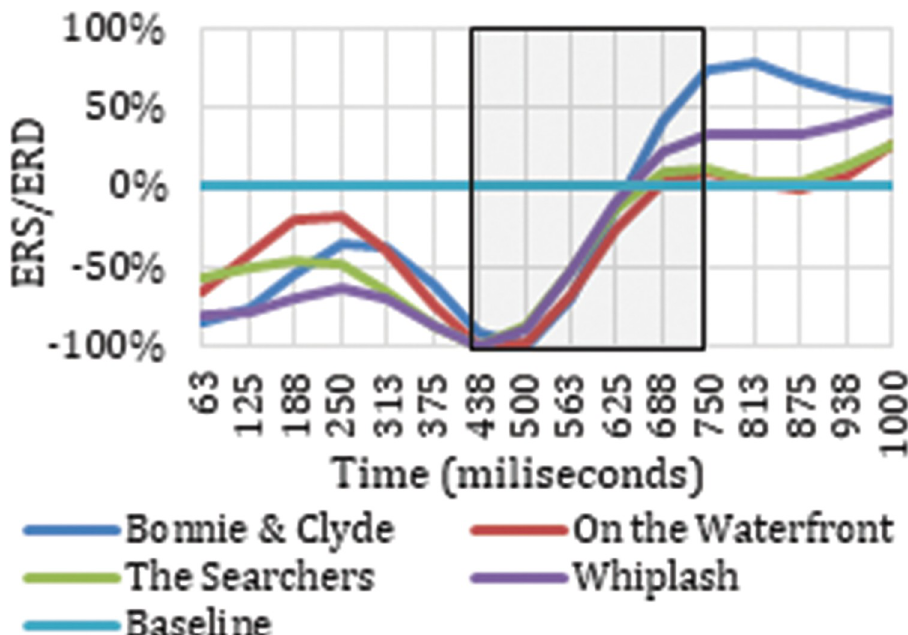
Fig 11. ERD/ERS from the four film excerpts for P4 electrode in low delta.